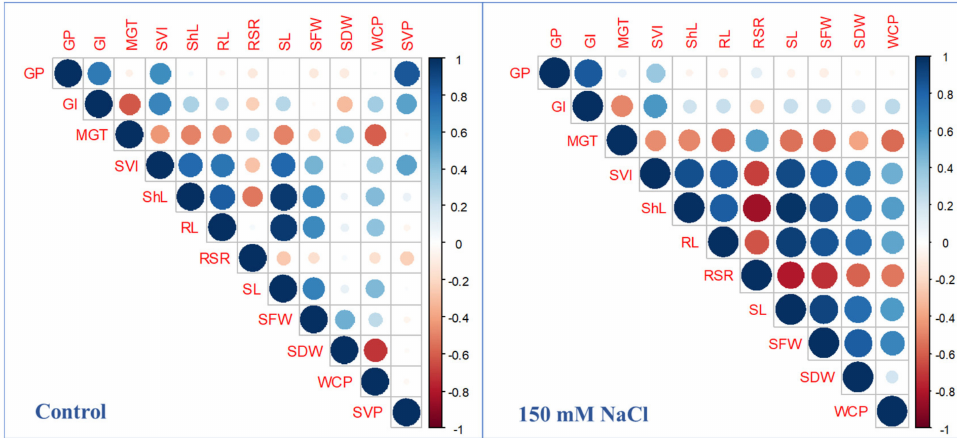
Figure 2. Pearson correlation coefficients among studied traits under control ( left ) and 150 mM NaCl conditions ( right ). Where, GP is germination percentage (%), GI is germination index, MGT is mean germination time (day), SVI is seedling vigor index, ShL is shoot length (cm), RL is root length (cm), RSR is root: shoot ratio, SL is seedling length (cm), SFW is seedling fresh weight (mg), SDW is seedling dry weight (mg), WCP is water content percentage (%), and SVP is seed viability percentage